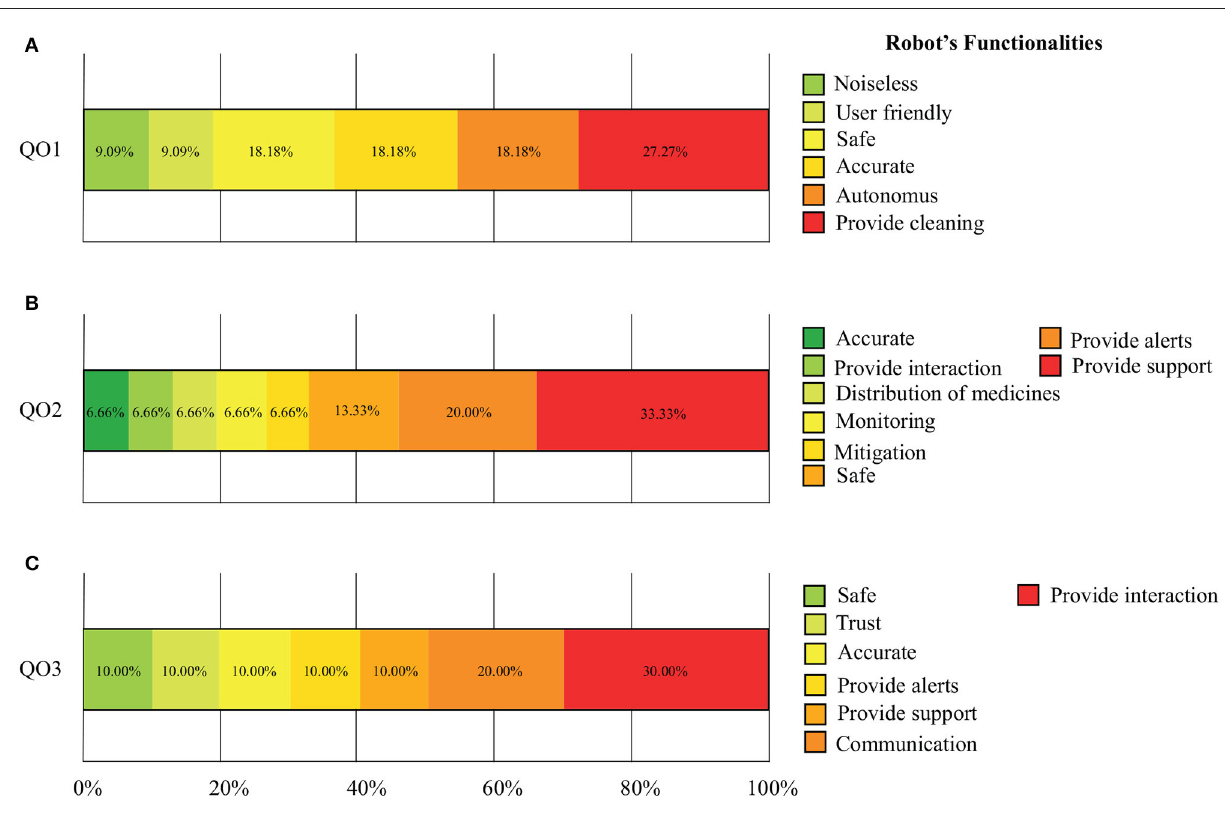
FIGURE 4 | Results of the proposed open questions to identify key functionalities of disinfection, assistance, and telemedicine robots. (A) Disinfection and Cleaning Robots. (B) Assistance, Service, and Logistics Robots. (C) Telemedicine and Telepresence